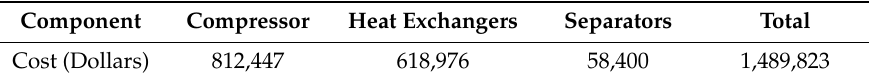
Table 6. Cost estimation of flare recovery